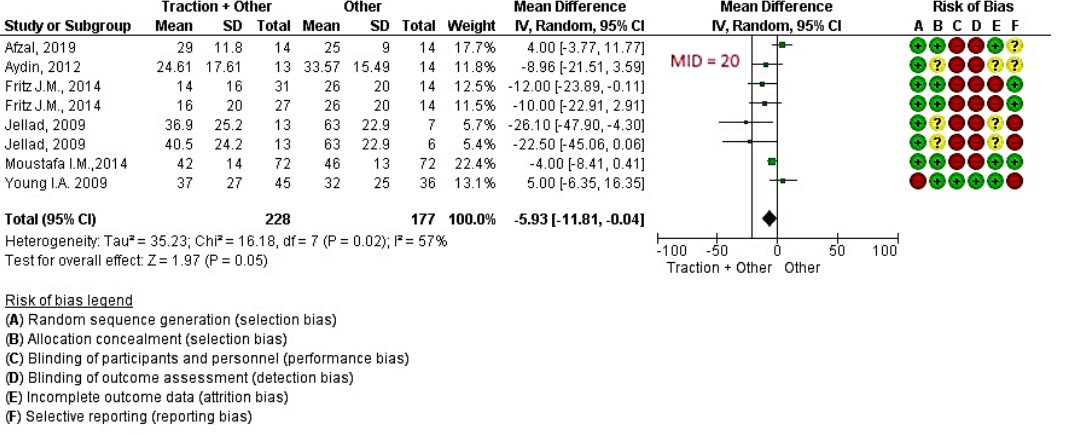
Figure 4. Effect of traction + other treatments versus other treatments for reducing pain in cervical radicular syndrome. Legend: Red (-) = high risk of bias; Yellow (?) = unknown risk of bias; Green (+) = low risk of bias; MID= Minimal important difference; IV= Inverse of Variance method.